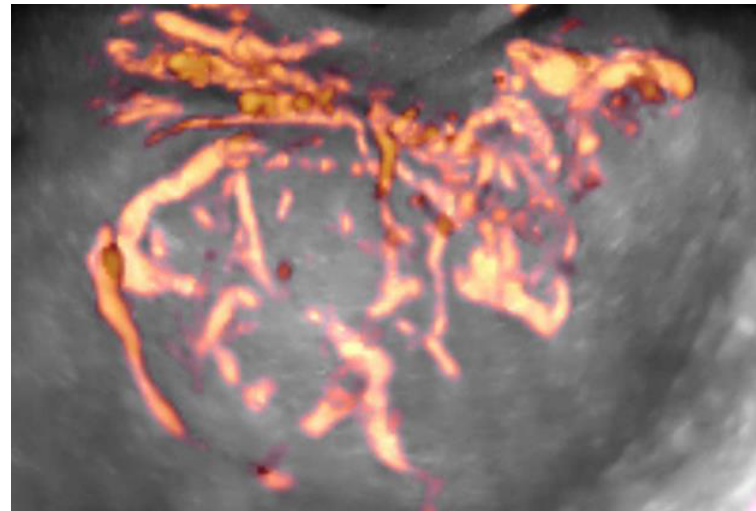
Figure 10. 3D Power Doppler spatial image of the net of vessels (yellow-red color areas) supplying an ovarian tumor (Glass Body option).